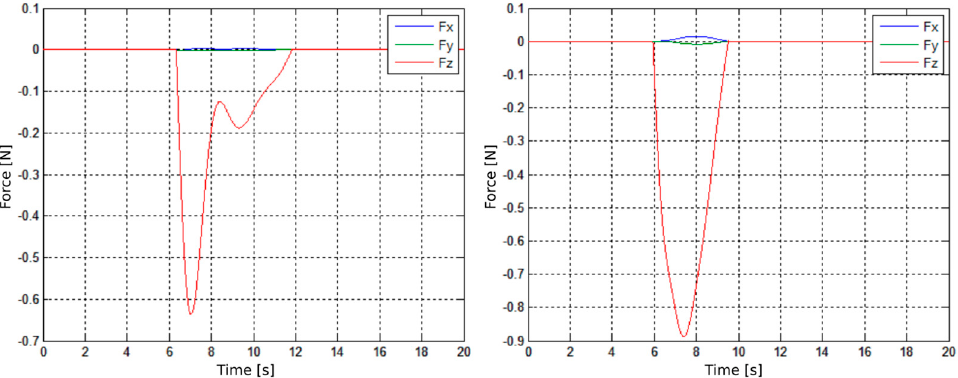
Figure 5. Contact force between the spheres simulating the end effector and the target. Left : model-based full robot impedance control, right : impedance control with a single prismatic joint at the end effector.